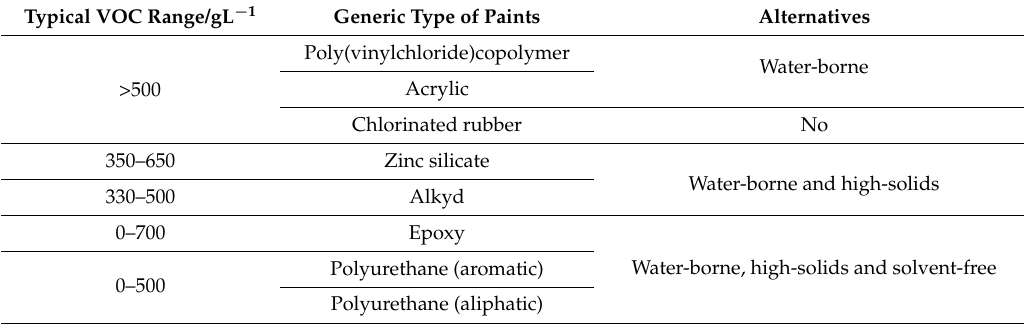
Table 11. Typical Volatile Organic Compound (VOC) range for generic type of